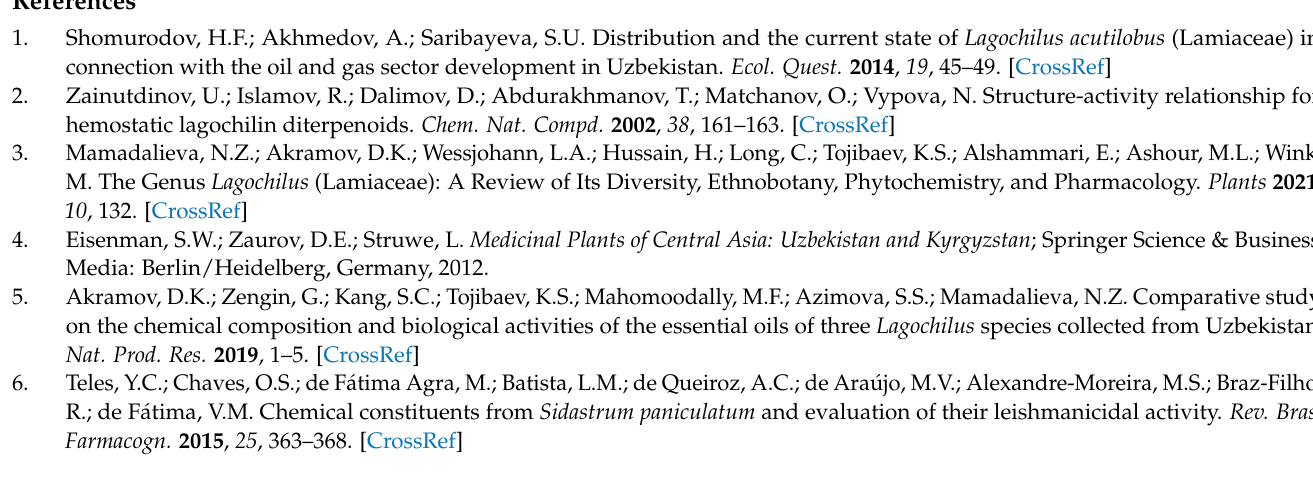
Figure S4: 13 C NMR spectrum of 1-methoxy-3- O - β -glucopyranosyl- α - L -oliose ( 1 ) in CD 3 OD, Figure S5: HSQC spectrum of 1-methoxy-3- O - β -glucopyranosyl- α - L -oliose ( 1 ) in CD 3 OD, Figure S6: HMBC spectrum of 1-methoxy-3- O - β -glucopyranosyl- α - L -oliose ( 1 ) in CD 3 OD, Figure S7: COSY spectrum of 1-methoxy-3- O - β -glucopyranosyl- α - L -oliose ( 1 ) in CD 3 OD, Figure S8: NOESY spectrum of 1- methoxy-3- O - β -glucopyranosyl- α - L -oliose ( 1 ) in CD 3 OD, Figure S9: IR spectrum of 1-methoxy-3- O - β -glucopyranosyl- α - L -oliose ( 1 ), Figure S10: UV spectrum of 1-methoxy-3- O - β -glucopyranosyl- α - L - oliose ( 1 ) in CH 3